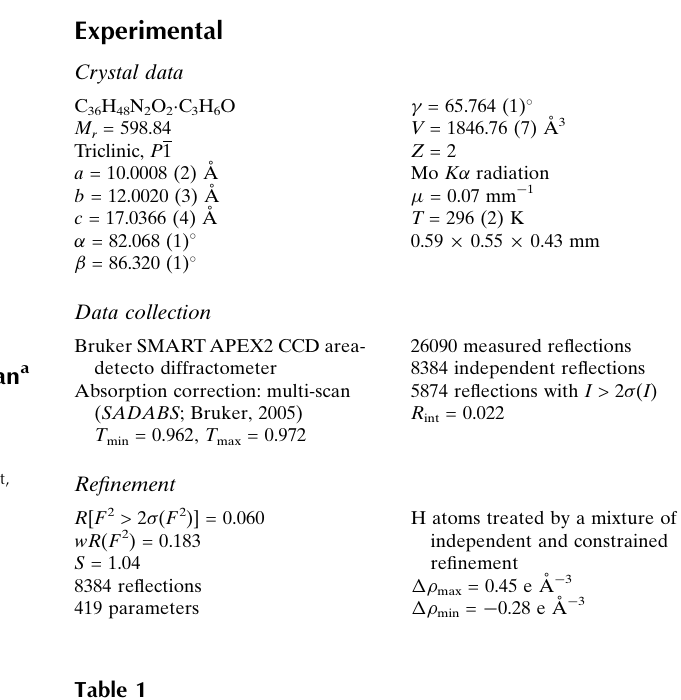
Hydrogen-bond geometry (A˚ , (cid:2) ). Cg 1 and Cg 2 are the C1–C6 and C15–C20 ring centroids,